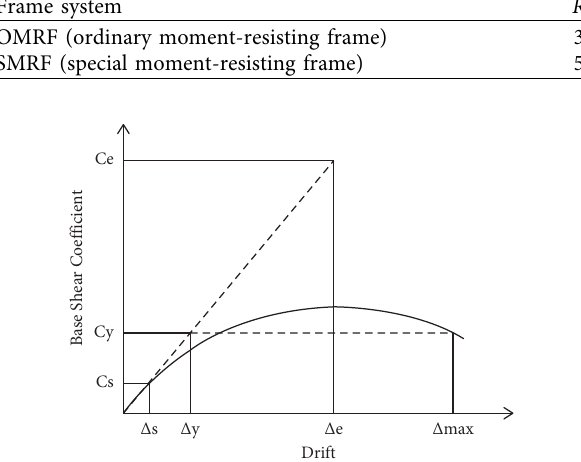
Figure 3: Inelastic behavior on seismic